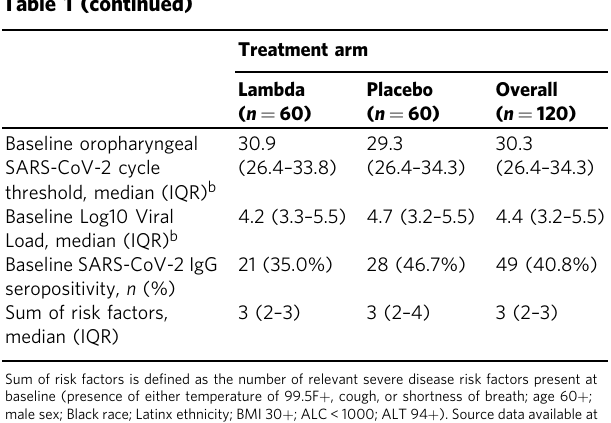
Table 1 Baseline characteristics of study